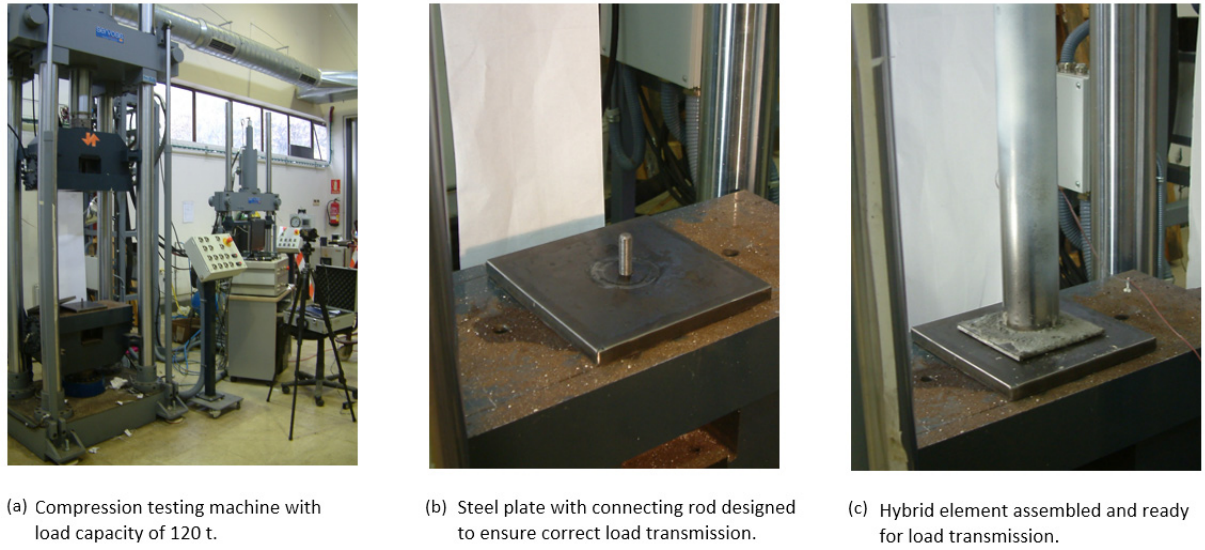
Figure 3. Preparation of the compression test of the hybrid elements: ( a ) Servosis 120 t universal testing machine, ( b ) load transmission plate with connecting rod, ( c ) assembled hybrid element assembled ready for load transmission.